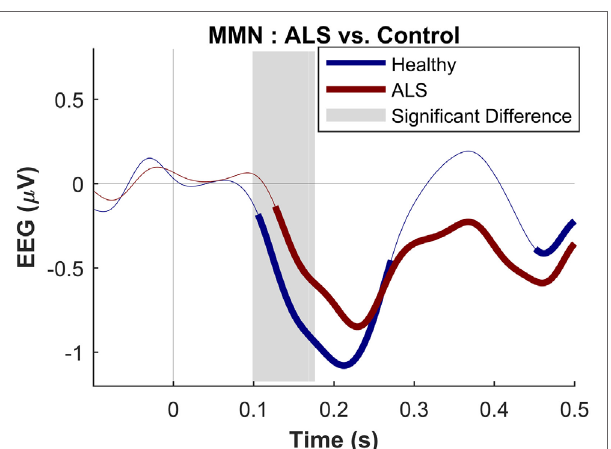
FigUre 4 | Presence of robust mismatch negativity responses in both patient and control groups. The auditory event-related potentials (ERPs) as well as their difference are shown. The shades indicate the SEM. See text for statistics and significance ( p < 0.05)